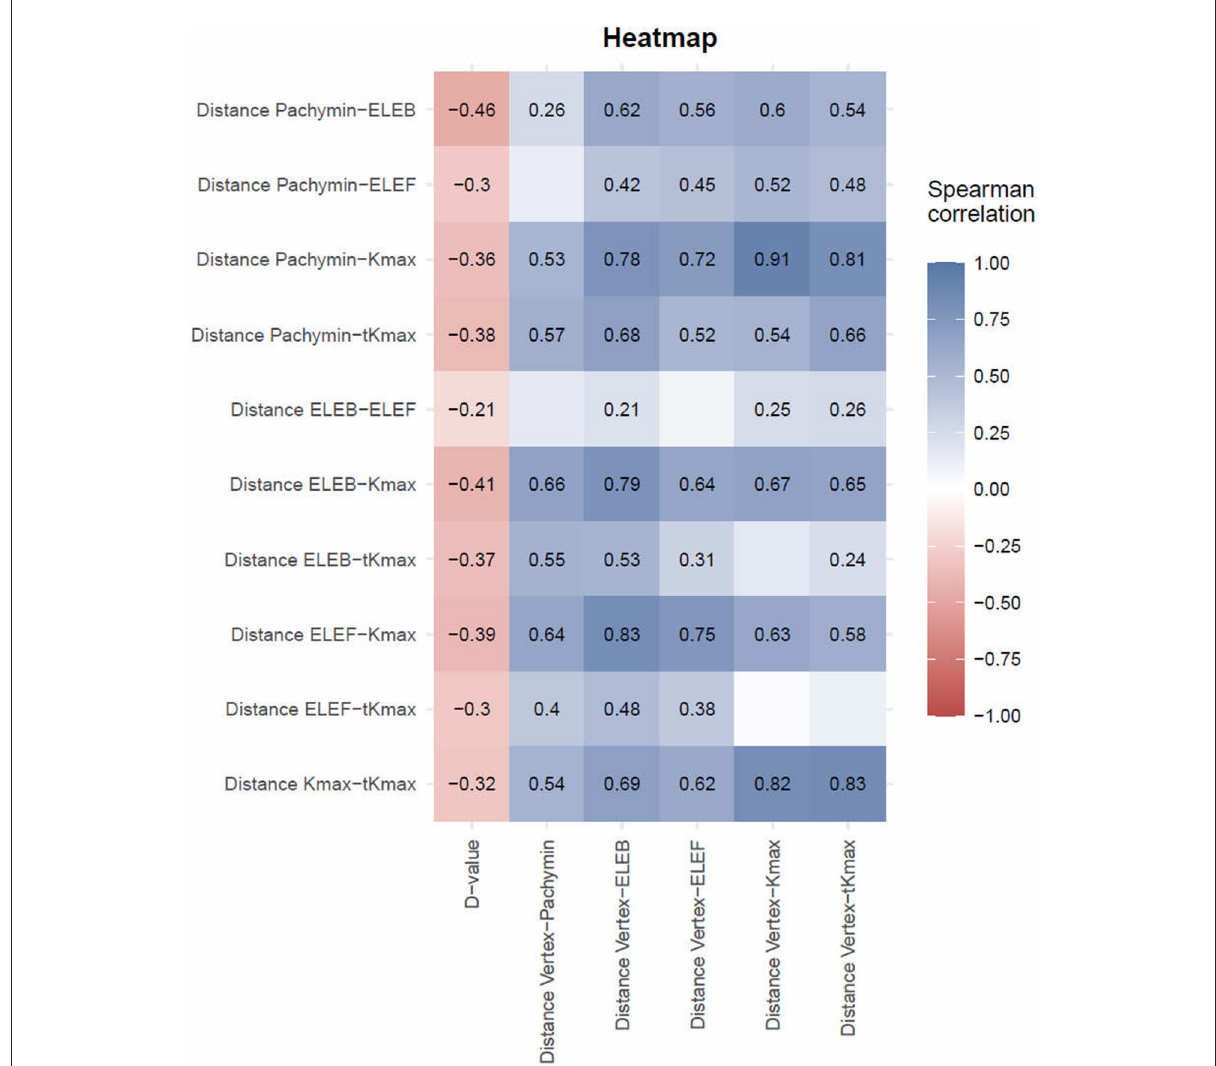
FIGURE3 Spearman Correlation between distances between locations of different tomographic parameters and D-values or distances between locations and corneal vertex. The Spearman correlation coefficient is only presented in fields reaching statistical significance ( p < 0.05). Discrepancy between different measures decreased with disease severity and increased with increasing distance from the corneal